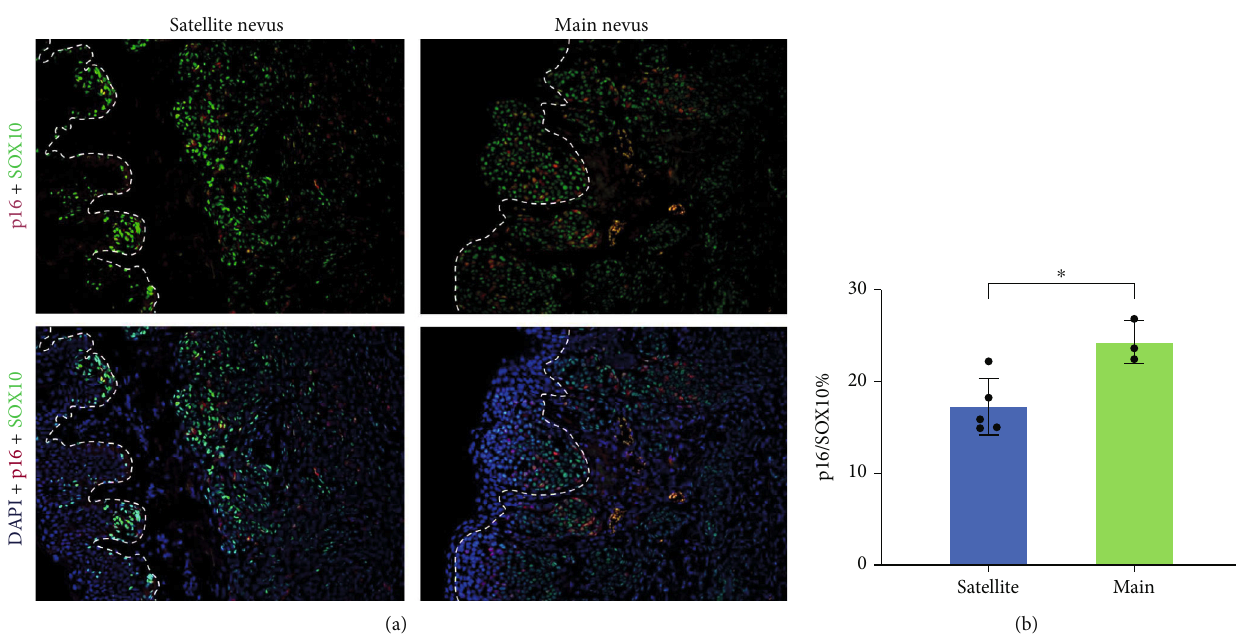
Figure 4: More nevocytes in lgCMN expressed p16 than in big satellite nevi. (a) Double immuno fl uorescence staining of SOX10 and p16 in lgCMNs and big satellite nevi (blue, DAPI; green, SOX10; red, p16; scale bar = 200 μ m). (b) Double-positive rates of SOX10 and p16 were compared between lgCMN and big satellite nevi ( ∗ p value <